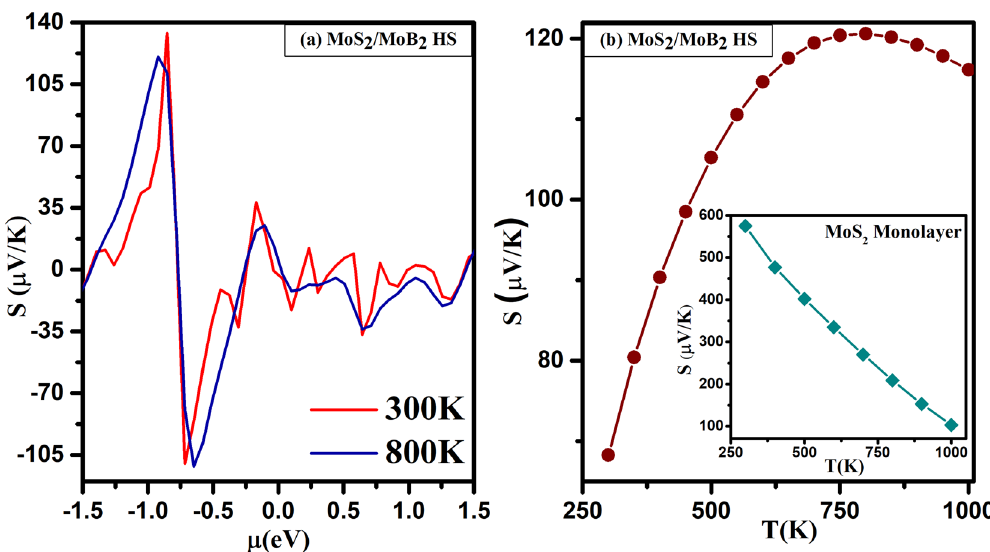
Figure 9. Seebeck coefficient (in μ V/K, where μ = 10 − 6 ) varying as a function of ( a ) chemical potential μ (in eV) and ( b ) Temperature T(K) of MoS 2 / MoB 2 HS and inset of ( b ) Temperature T(K) of MoS 2